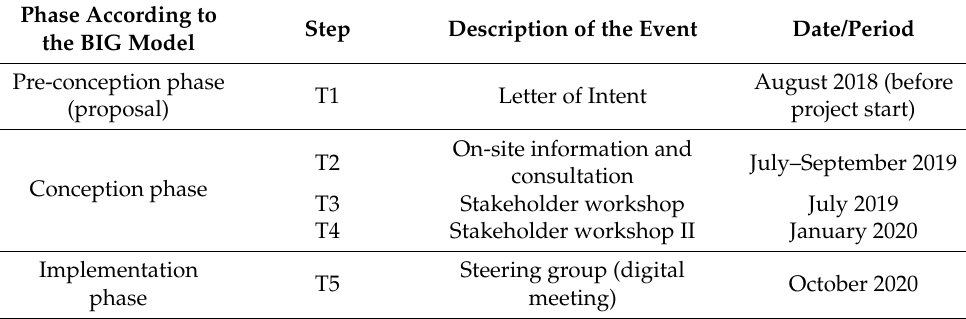
Table 1. Work steps and points in time of the data collection. Phase According